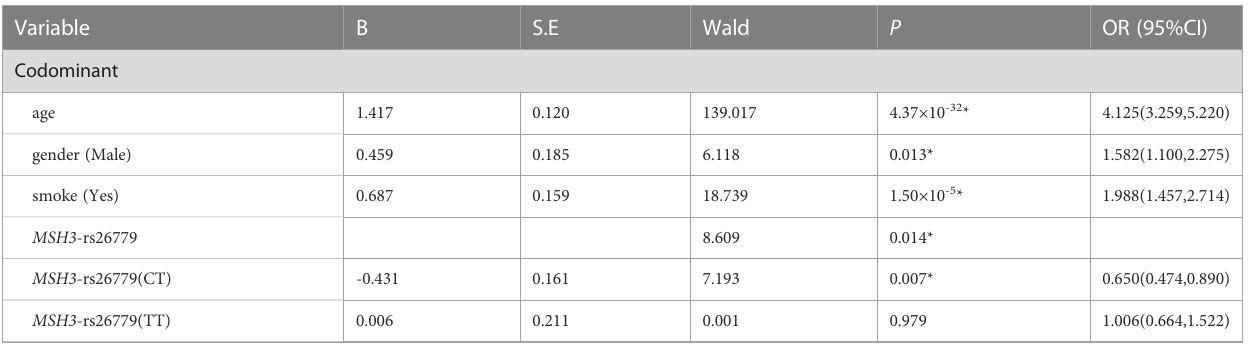
TABLE 7 Multiple logistic regression analysis of predictive factors for hepatocellular carcinoma between CHB and HCC in three models. Variable